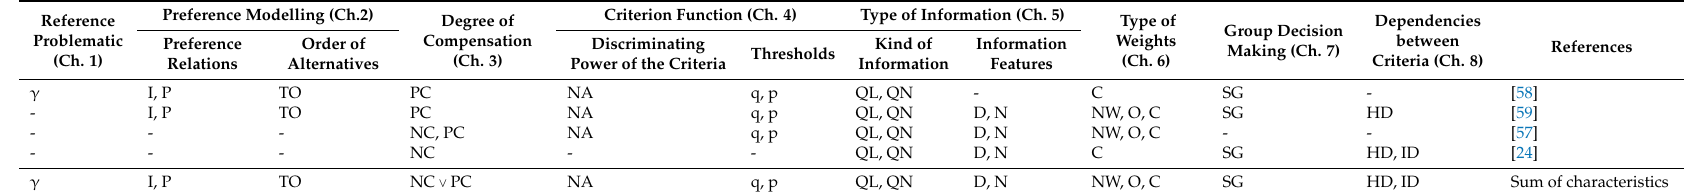
Table 4. Recommendations of characteristics of an MCDA method suitable for applying in RES and sustainability problems.